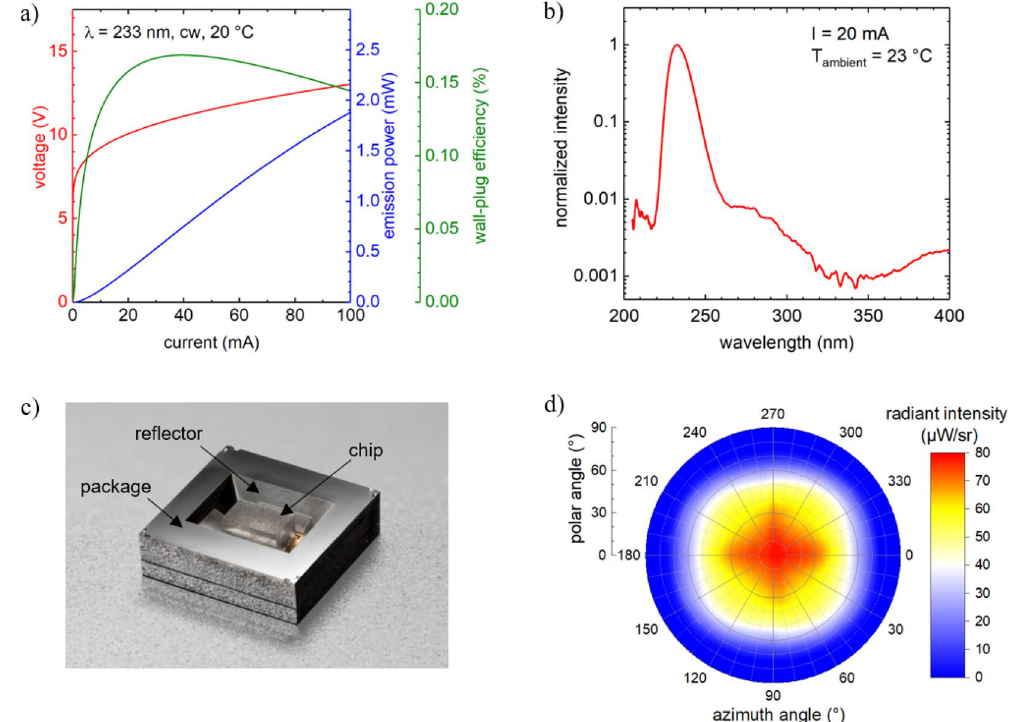
Figure 1. ( a ) Voltage, wall-plug efficiency and optical power as a function of current of a typical flip- chip mounted 233 nm LED used in the irradiation module. ( b ) Emission spectrum of the LED operated at 20 mA. ( c ) Image of a 233 nm LED flip-chip mounted on a Si-cavity surface-mounted device package (footprint = 3.5 mm × 3.5 mm). ( d ) Far-field radiation distribution measured of a typical 233 nm LED operated at 20